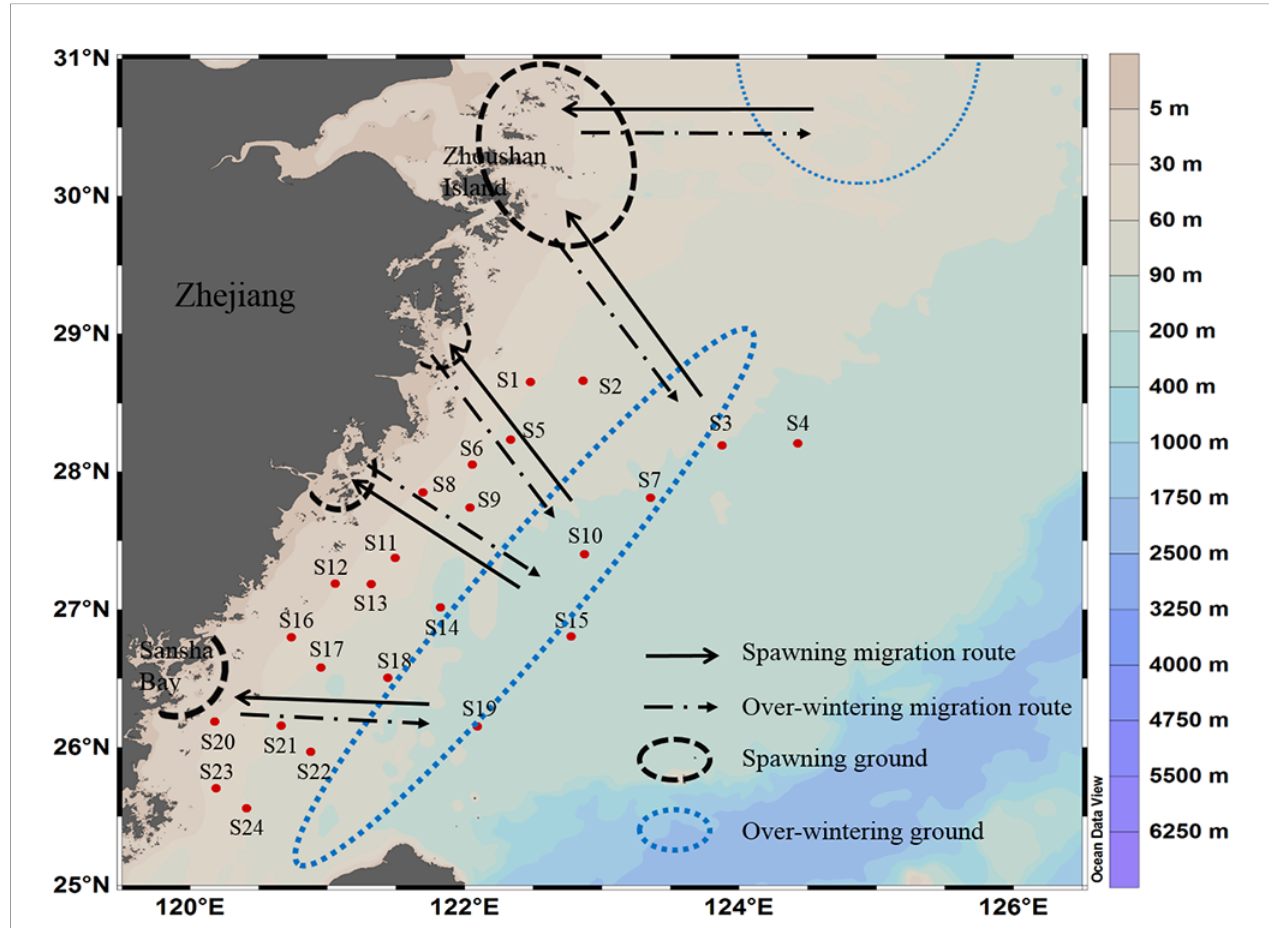
FIGURE 1 | Map of survey sites of Larimichthys crocea . The spawning ground, overwintering ground, and migration route of L. crocea in the East China Sea, modi fi ed from Wang et al.